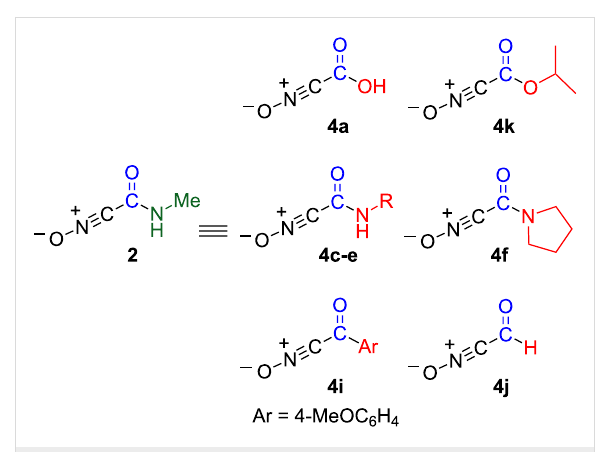
Figure 1: Versatile functionalized nitrile